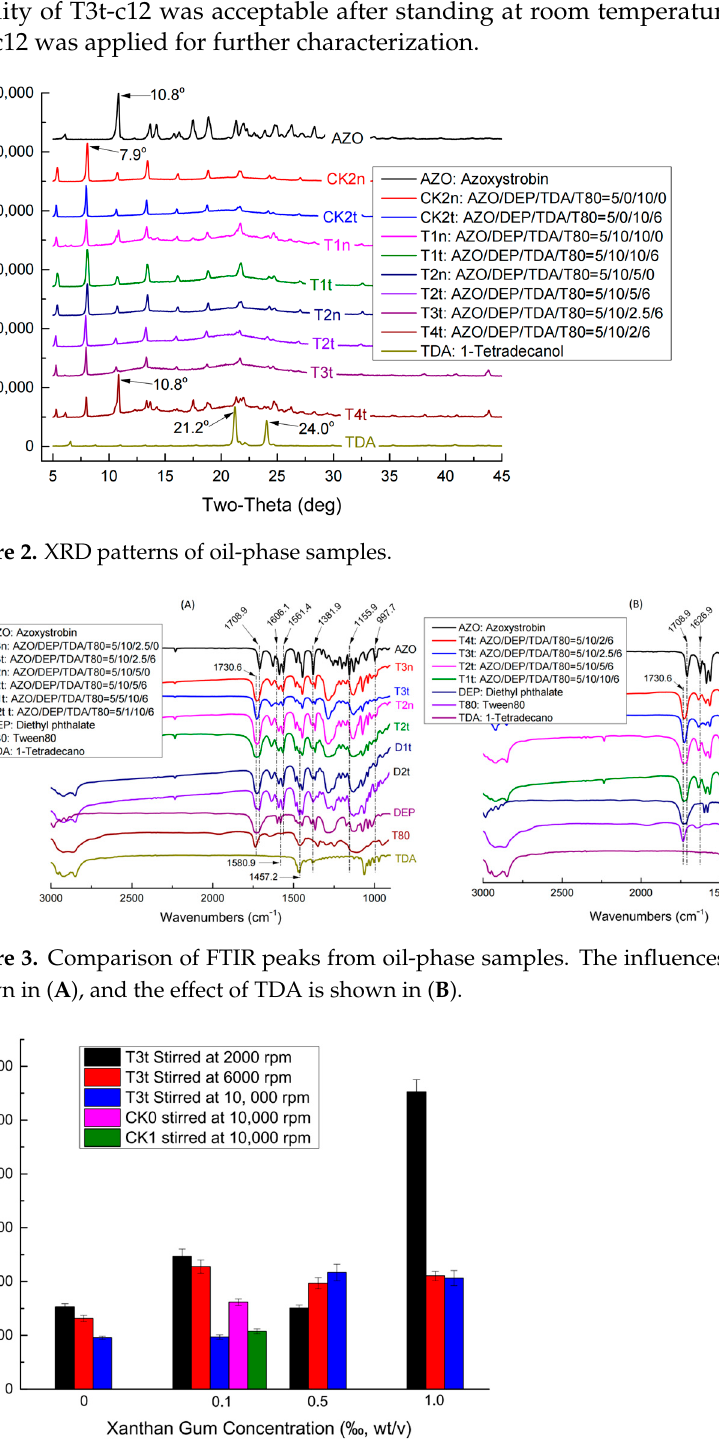
Figure 4. Particle sizes of AZO-loading NPs prepared with nonionic emulsifier (T80).